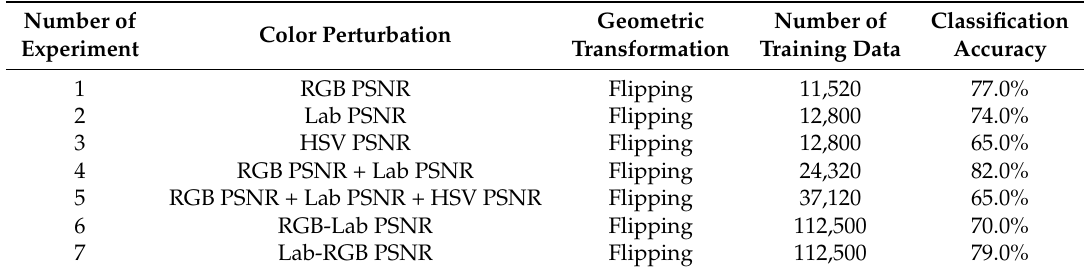
Table 5. Classification accuracy obtained upon applying the inverse PSNR method and Geometric Transformation #1: flipping.